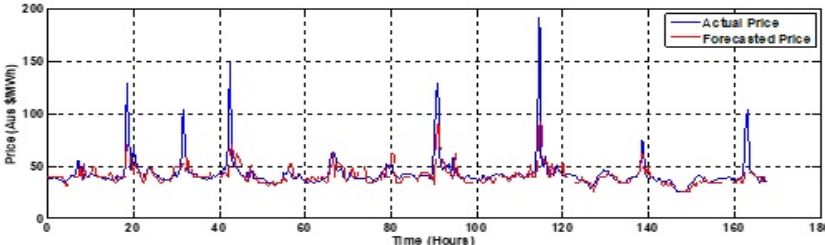
Figure 10. September 1–7, 2015 forecasting with the maximum number of features selected in the spring season (MAPE = 11.23).